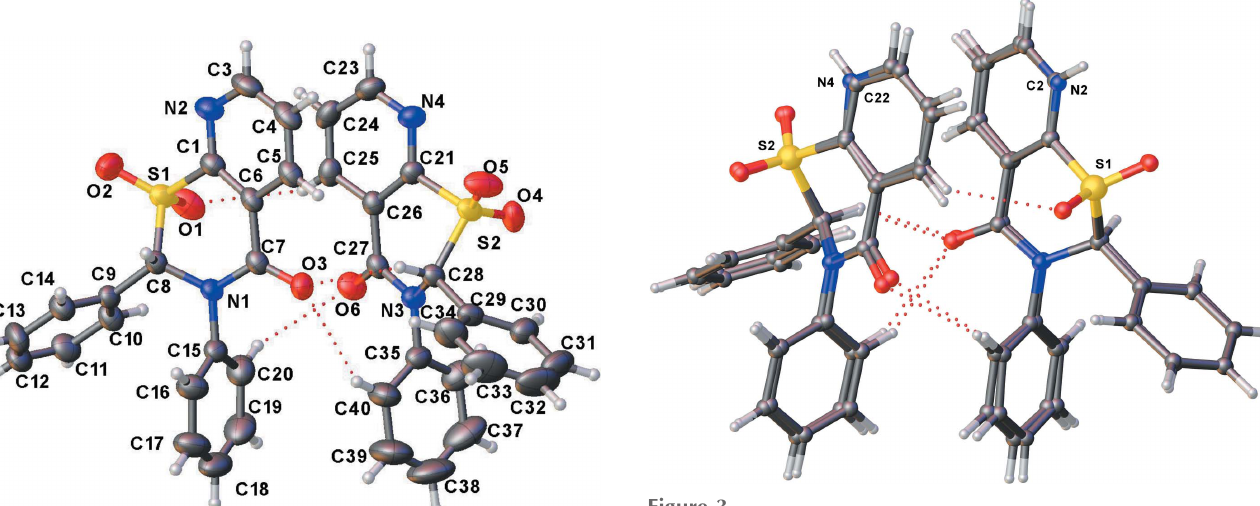
Figure 3 Overlay plot of 1 and 2 where atoms S1 and S2 of the two structures are matched. The atoms that differ in the two structures, namely C2 and C22 of 1 and N2 and N4 of 2 , are